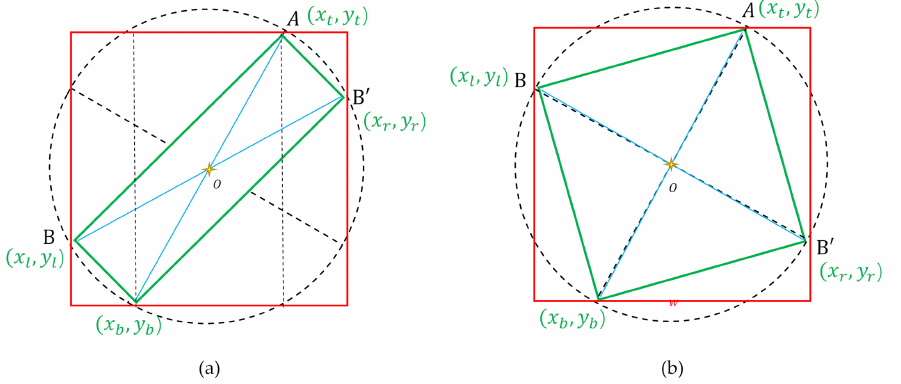
Figure 8. Soft constraints. ( a , b ) detail two rotating bounding box situations. Take point O as the center of the circle and BB (cid:48) as the diameter. According to Thales’ theorem, the angle ∠ BAB (cid:48) is a right